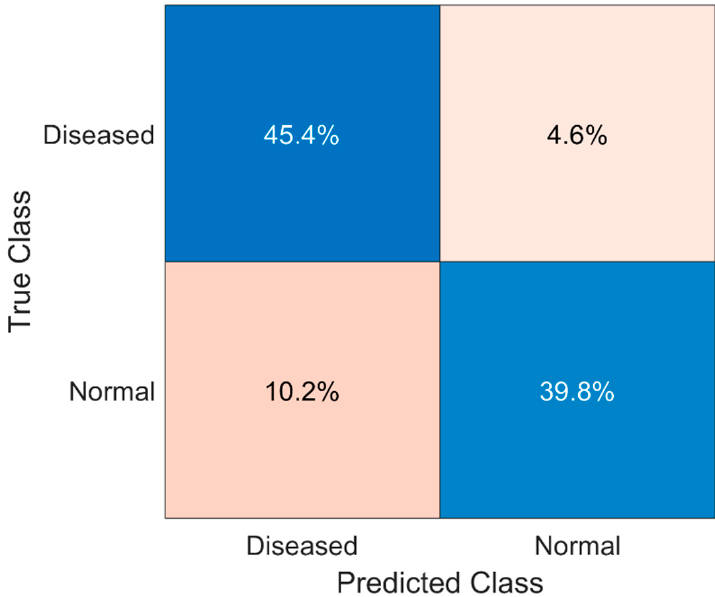
Figure 11. Confusion matrix for fine-tuned 3D U-Net classifier-based classification results.